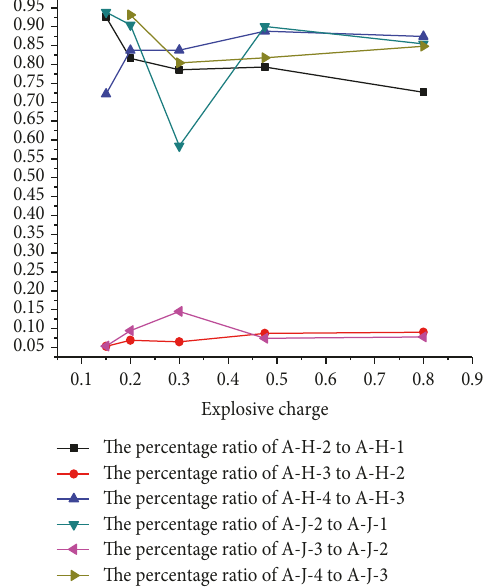
Figure 14: Percentage ratio of strain at each measurement point of Model